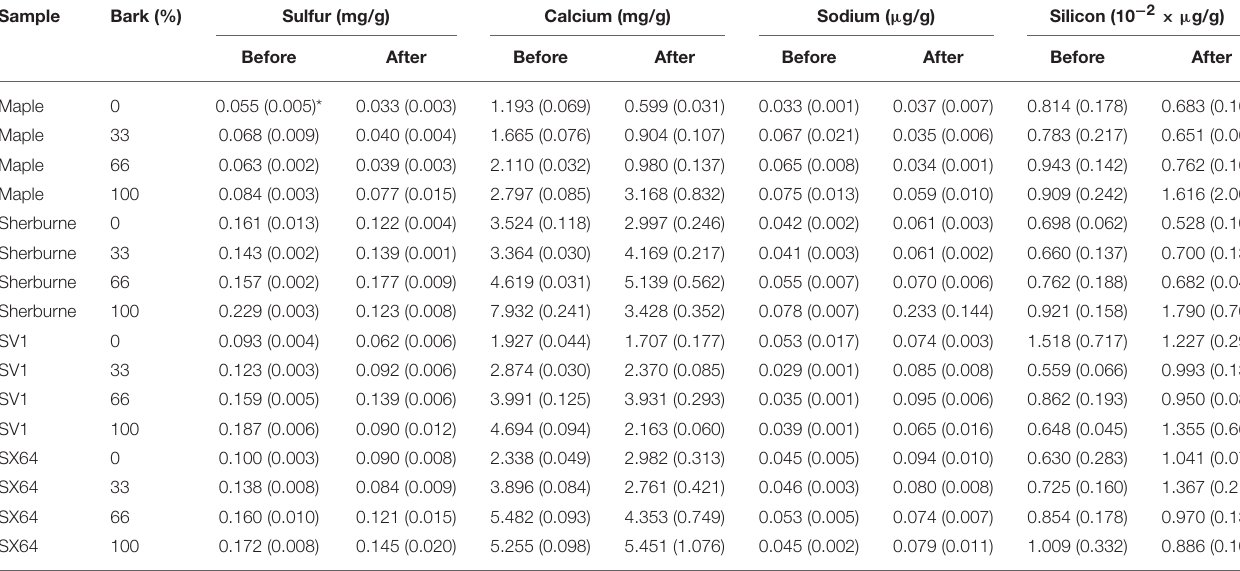
TABLE 3 | Calcium, sodium, sulfur and silicon contents of sugar maple and three willow cultivars with bark levels ranging from 0 to 100% before and after HWE.